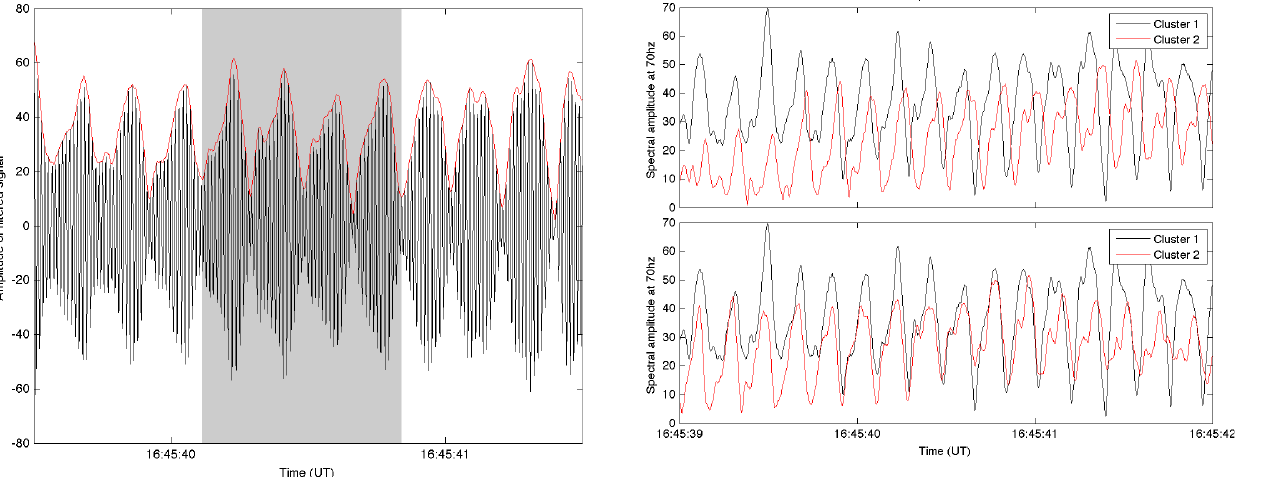
Fig. 2. Structure of wave packets observed by Cluster 1 on